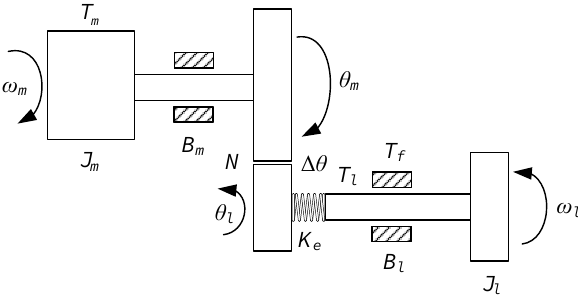
Figure 4. The structure diagram of the gimbal servo system.